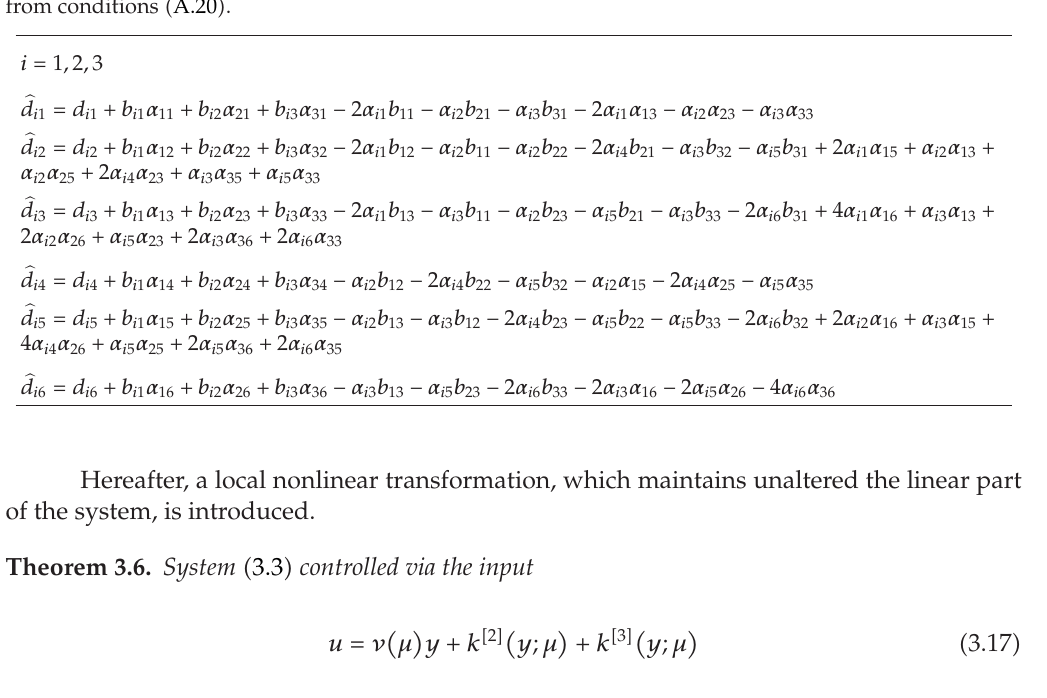
Table 3: Relationships between the coe ffi cients of g (cid:4) 1 (cid:5) (cid:3) z (cid:6) and those of (cid:17) g (cid:4) 2 (cid:5) (cid:3) z (cid:6) and ϕ (cid:4) 2 (cid:5) (cid:3) z (cid:6) as they result from conditions (cid:3) A.20 (cid:6)